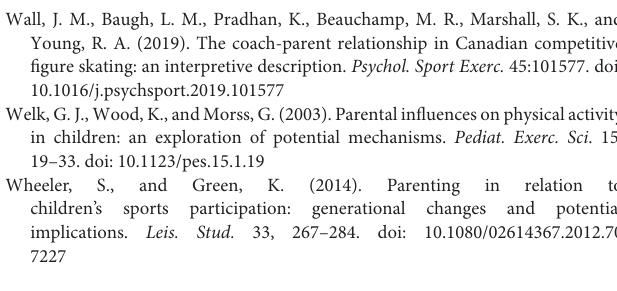
figure skating: an interpretive description. Psychol. Sport Exerc. 45:101577. doi: